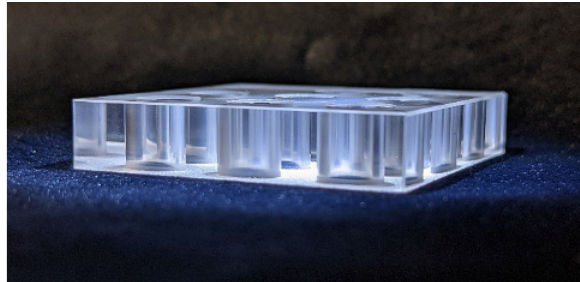
Fig. 6. Fused silica cuboid with ultra-fine grinded